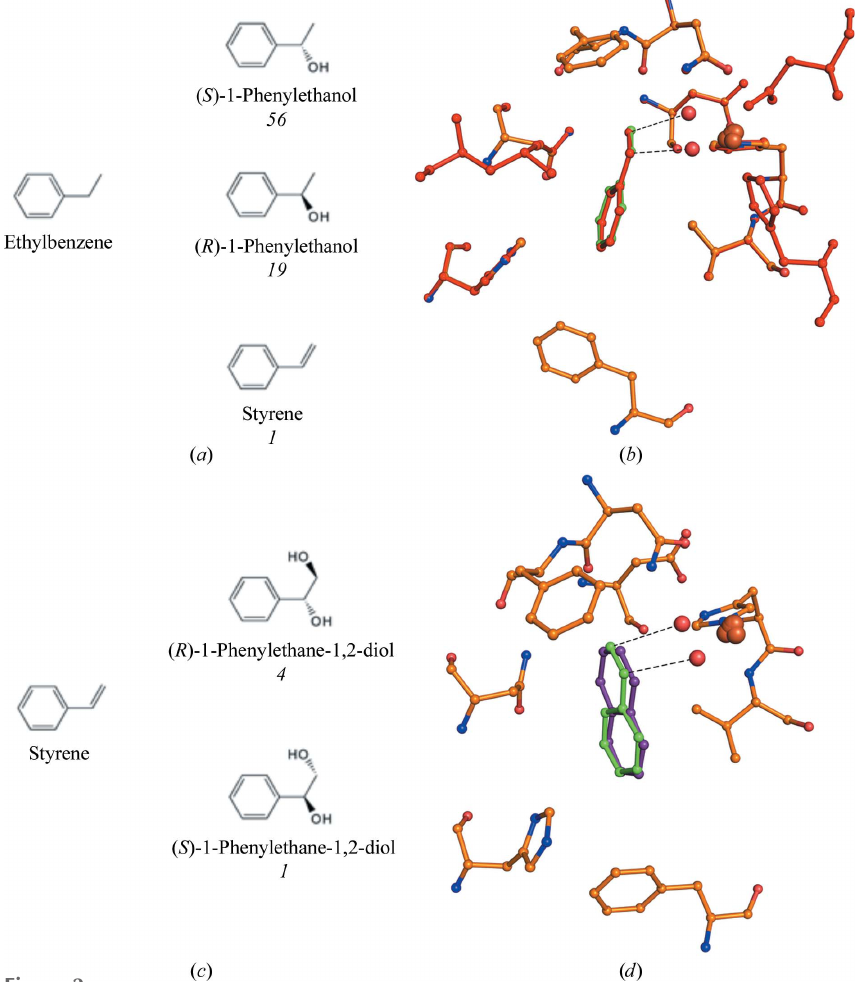
Figure 2 ( a , c ) Products formed with ethylbenzene ( a ) and styrene ( c ) as substrates. Approximate ratios of product detected in biotransformation assays are shown in italics below the products. ( b , d ) Wild- type NDO in complex with styrene (green) overlapped with that with naphthalene (purple) ( d ) and that with ethylbenzene (red) overlapped with that with styrene ( b ). Active-site residues are represented by sticks with orange C atoms. The mononuclear iron (large orange sphere) and modeled dioxygen from PDB entry 1o7n (small red spheres) are also